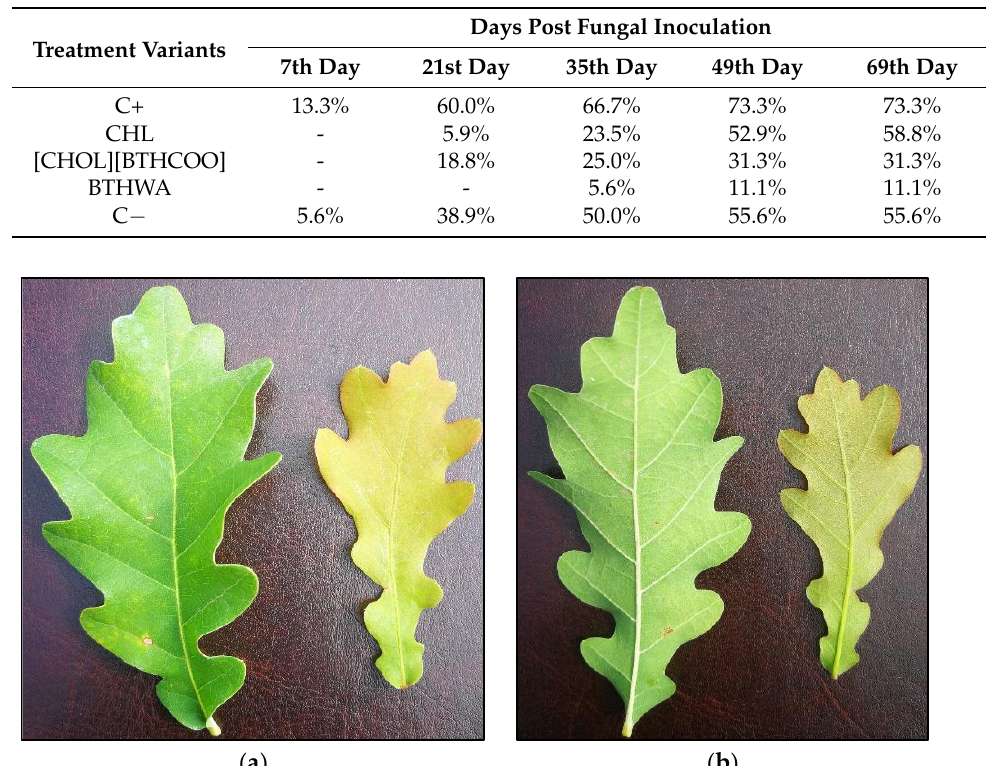
Figure 1. Oak leaves (mature — Left; juvenile — Right) with no symptoms of powdery mildew after 69 days of fungal inoculation and five treatments with BTHWA: ( a ) upper side; ( b ) bottom side.